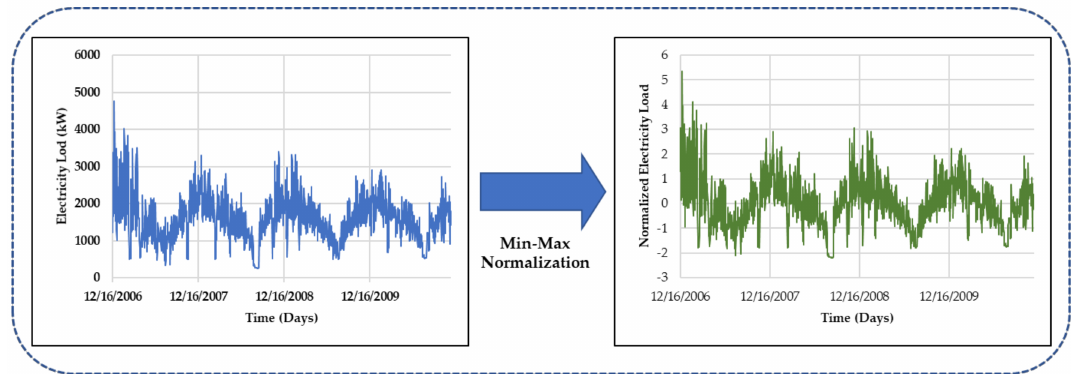
Figure 7. Normalizing the actual electricity consumption data using min–max